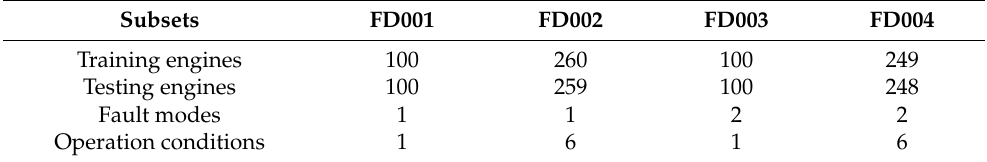
Table 1. The details of C-MAPSS dataset